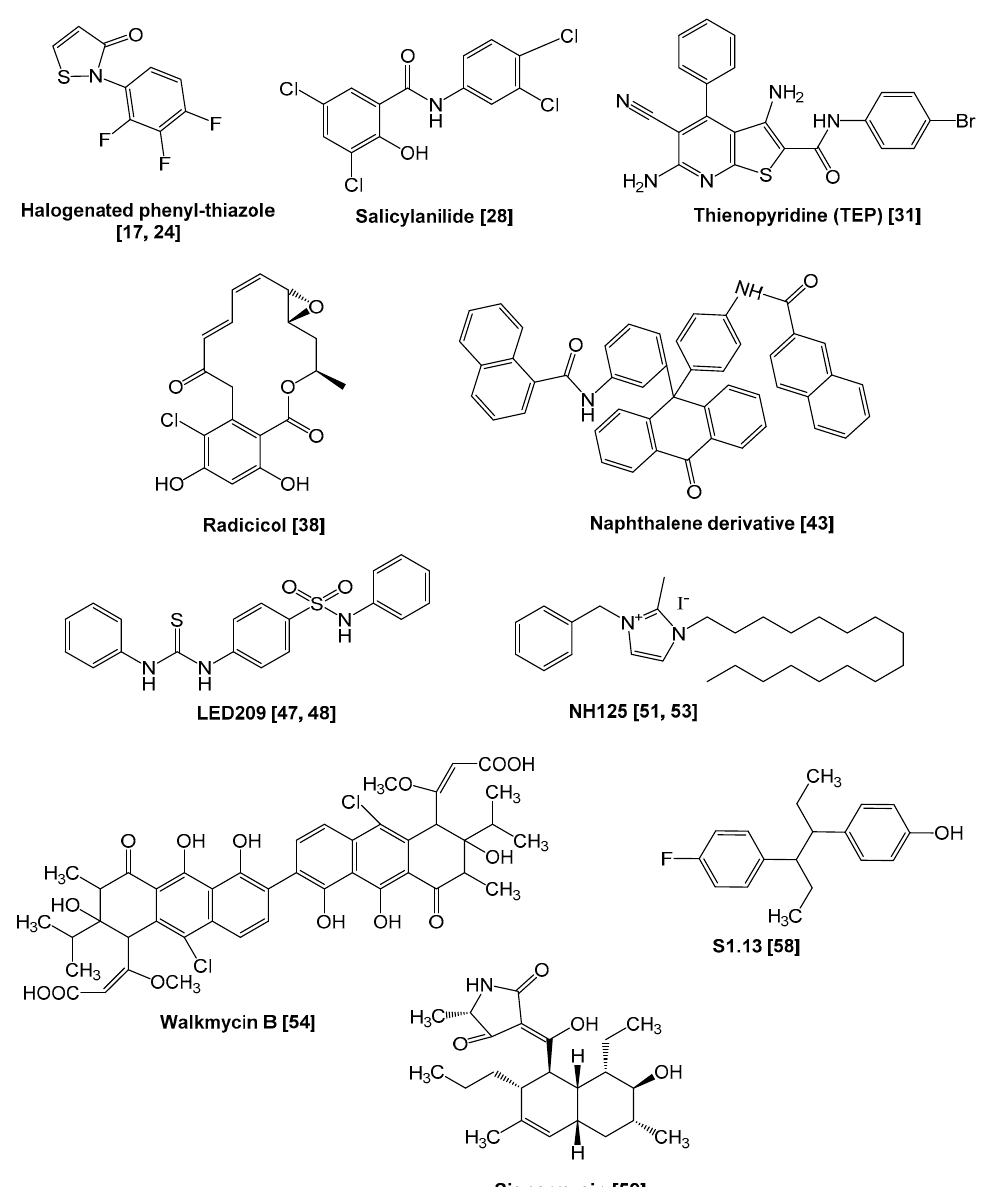
Figure 2. Chemical structures of representative sensor kinase inhibitors.